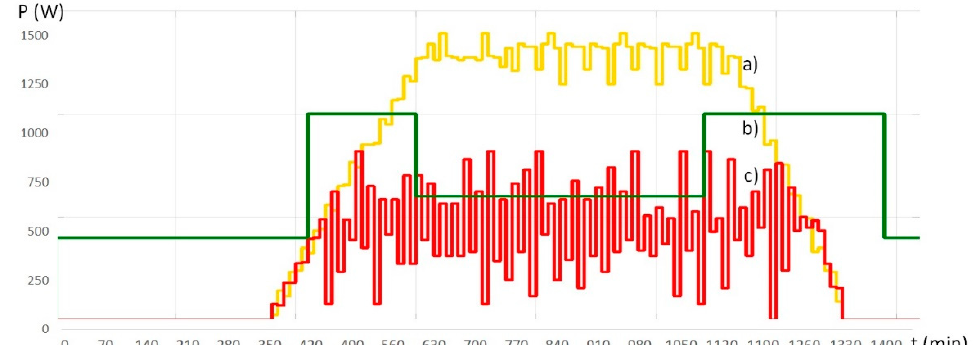
Figure 11. The graph of simulation process input: ( a ) the PV plant production profile for a sunny day (yellow), ( b ) the consumer request profile (green), and ( c ) the PV plant production profile for a cloudy day (red).